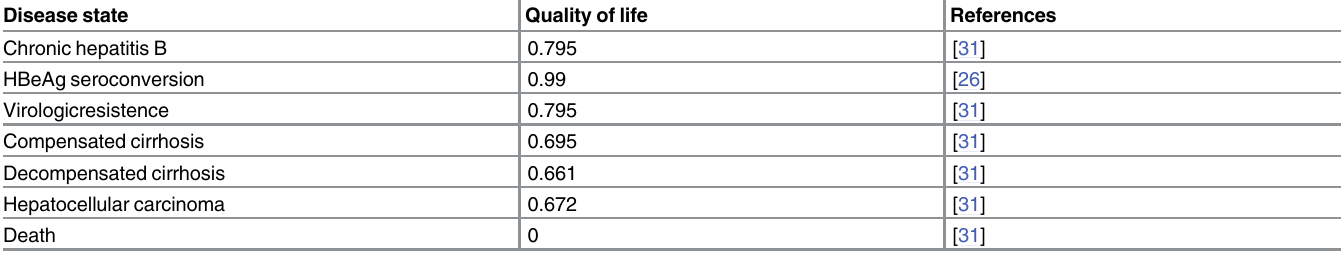
Table 3. Base-case health